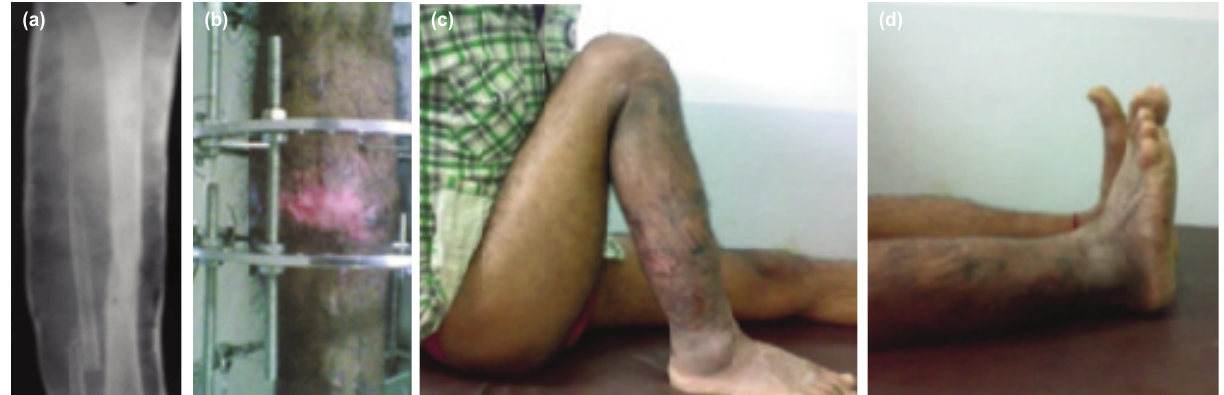
(a) Final follow-up radiograph of a case treated by IBT. (b) clinical picture before ring removal. (c) Clinical picture showing ROM Fig. 4: of knee flexion. (d) clinical picture showing ROM of ankle plantar flexion. (e) Clinical picture showing ROM of ankle